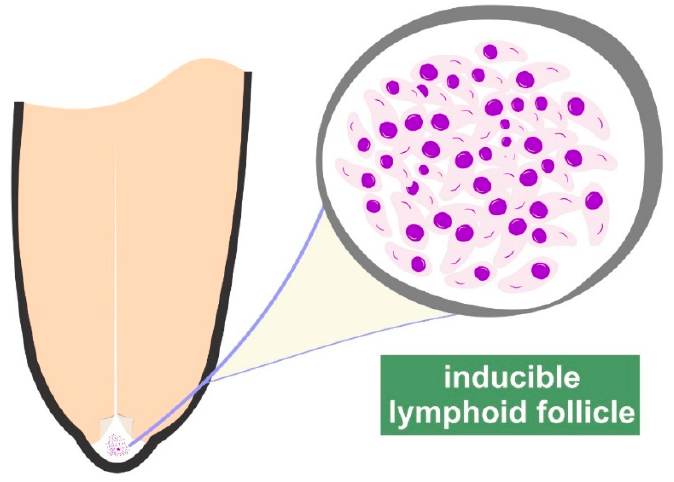
Figure 1. Graphic illustration of the inducible lymphoid follicles in the teat of ewes.